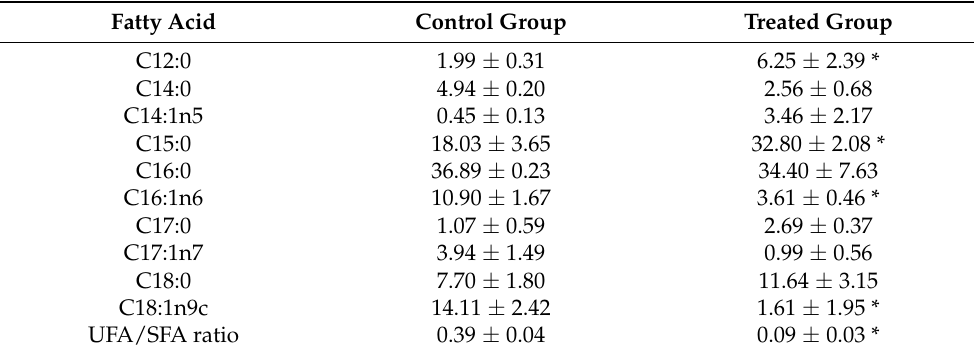
Table 2. Effect of sodium hypochlorite on fatty acid composition of S .